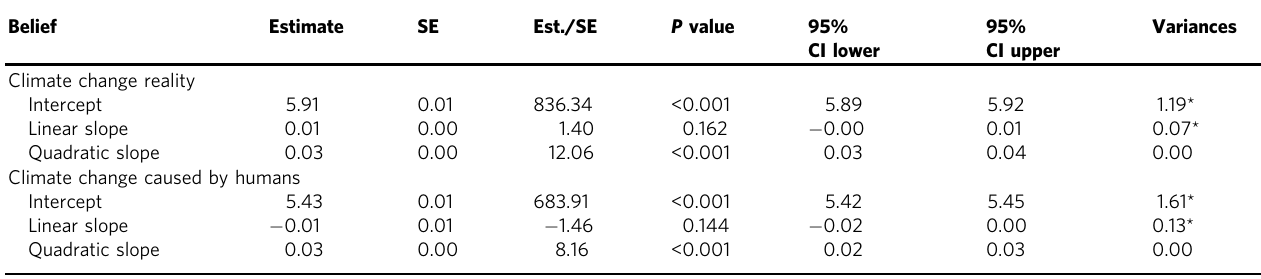
Table 2 Parameter coef fi cients for the cohort-constrained models for climate change reality and human causation estimating the change trajectory from ages 18 to